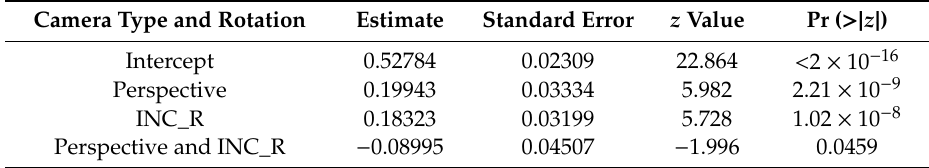
Table 11. Logistic regression results concerning the variables camera type and rotation by allowing interactions.